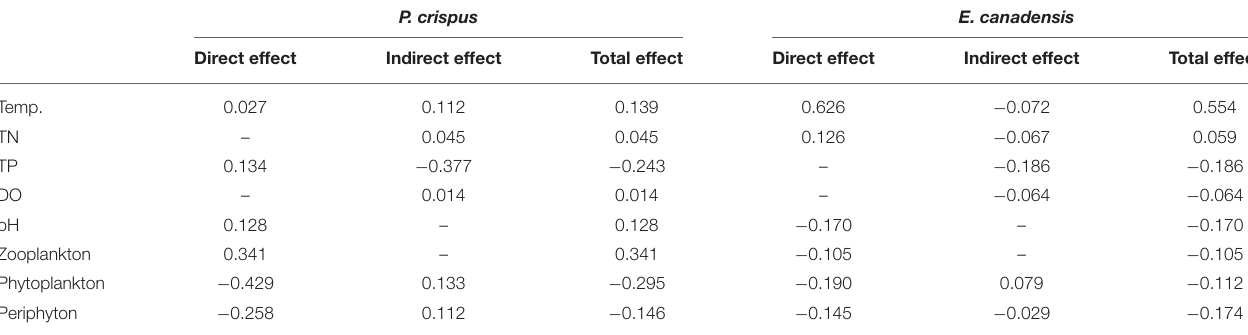
TABLE 1 | Standardized total, direct, and indirect effects of environmental factors on the biomass of submerged macrophytes in the SEM diagram. P. crispus E.